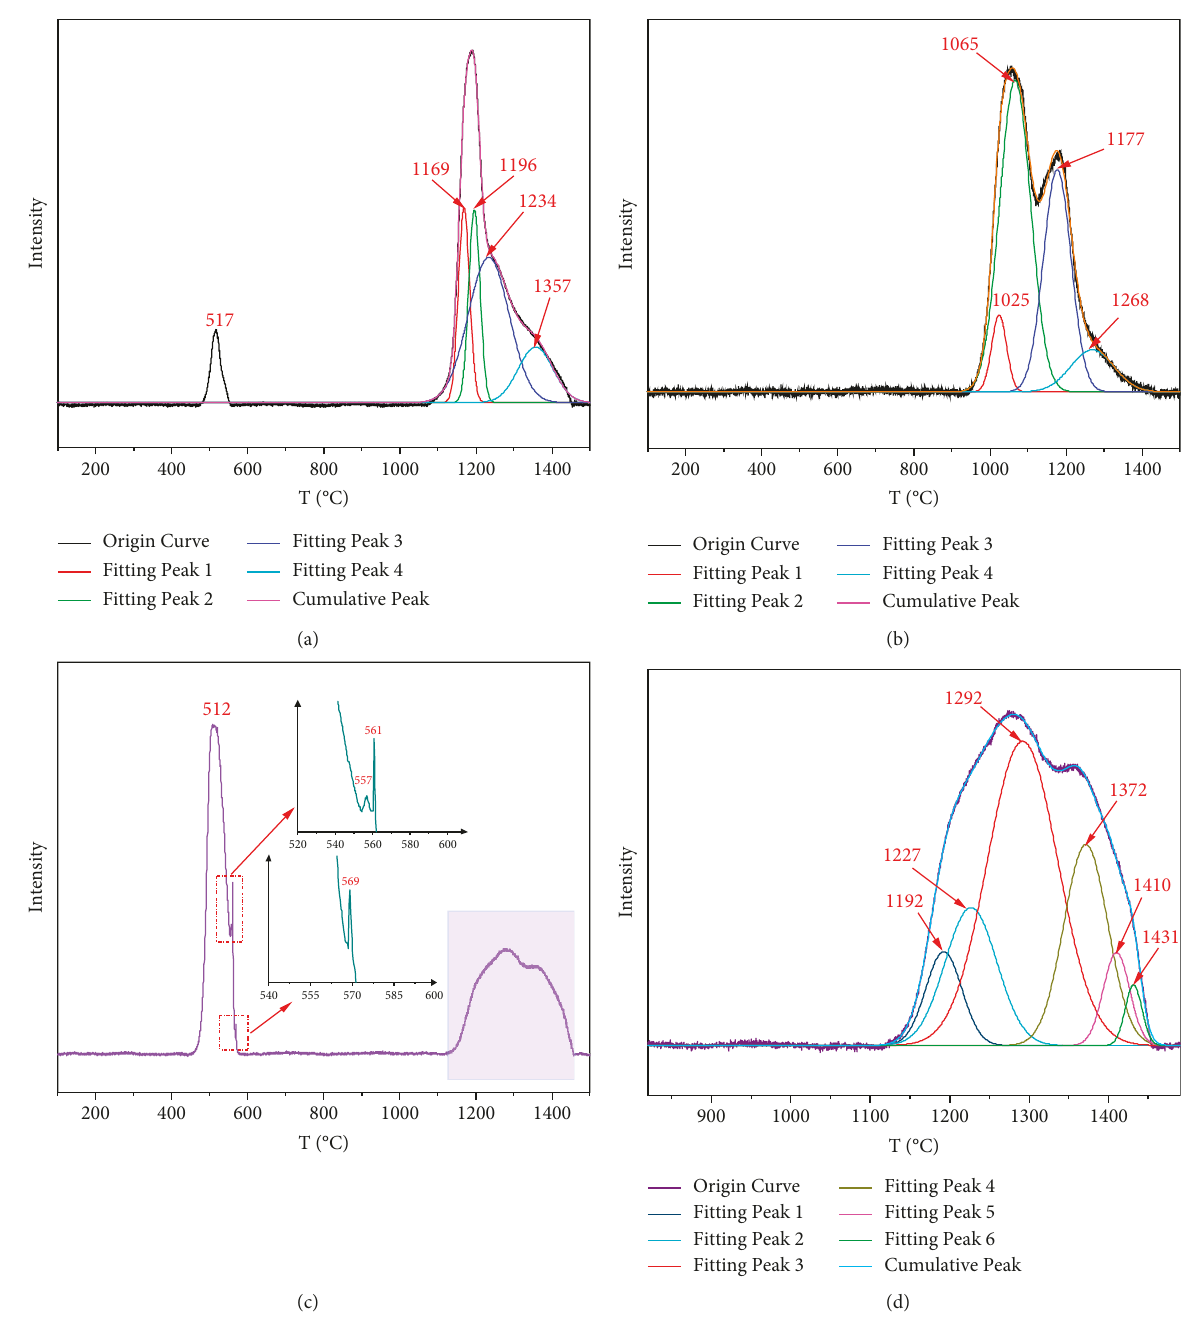
Figure 4: TPO-IR profiles of WAP (a), ZJP (b), and KYP (c), and locally magnified KYP